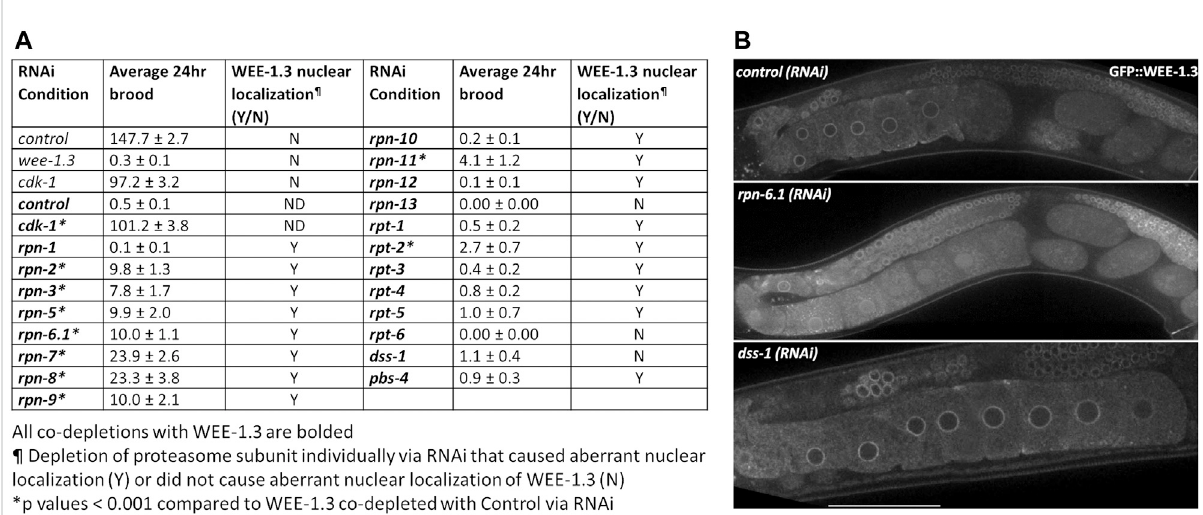
FIGURE 6 WEE-1.3 function and localization are altered by depletion of speci fi c proteasome subunits. (A) Average 24 h brood and WEE-1.3 nuclear localization status of hermaphrodites treated with either control(RNAi), wee-1.3(RNAi), cdk-1(RNAi) individually or co-depleted with WEE-1.3, or 19S RP subunits co-depleted with WEE-1.3 via RNAi (all co-depletions with WEE-1.3 are bolded). All co-depletion conditions were compared to WEE- 1.3 co-depleted with the control RNAi condition. * represents p values < 0.001, Y (yes) or N (No) represents whether or not aberrant nuclear localization of WEE-1.3 occur when control or proteasome subunits depleted individually. ND indicated not determined. (B) Live imaging of gonads from strain WDC2 wee-1.3[ana2(gfp::wee-1.3)] treated with either control(RNAi), rpn-6.1(RNAi) or dss-1(RNAi) . All images were taken at the same laser intensity and PMT gain. Scale bar, 100